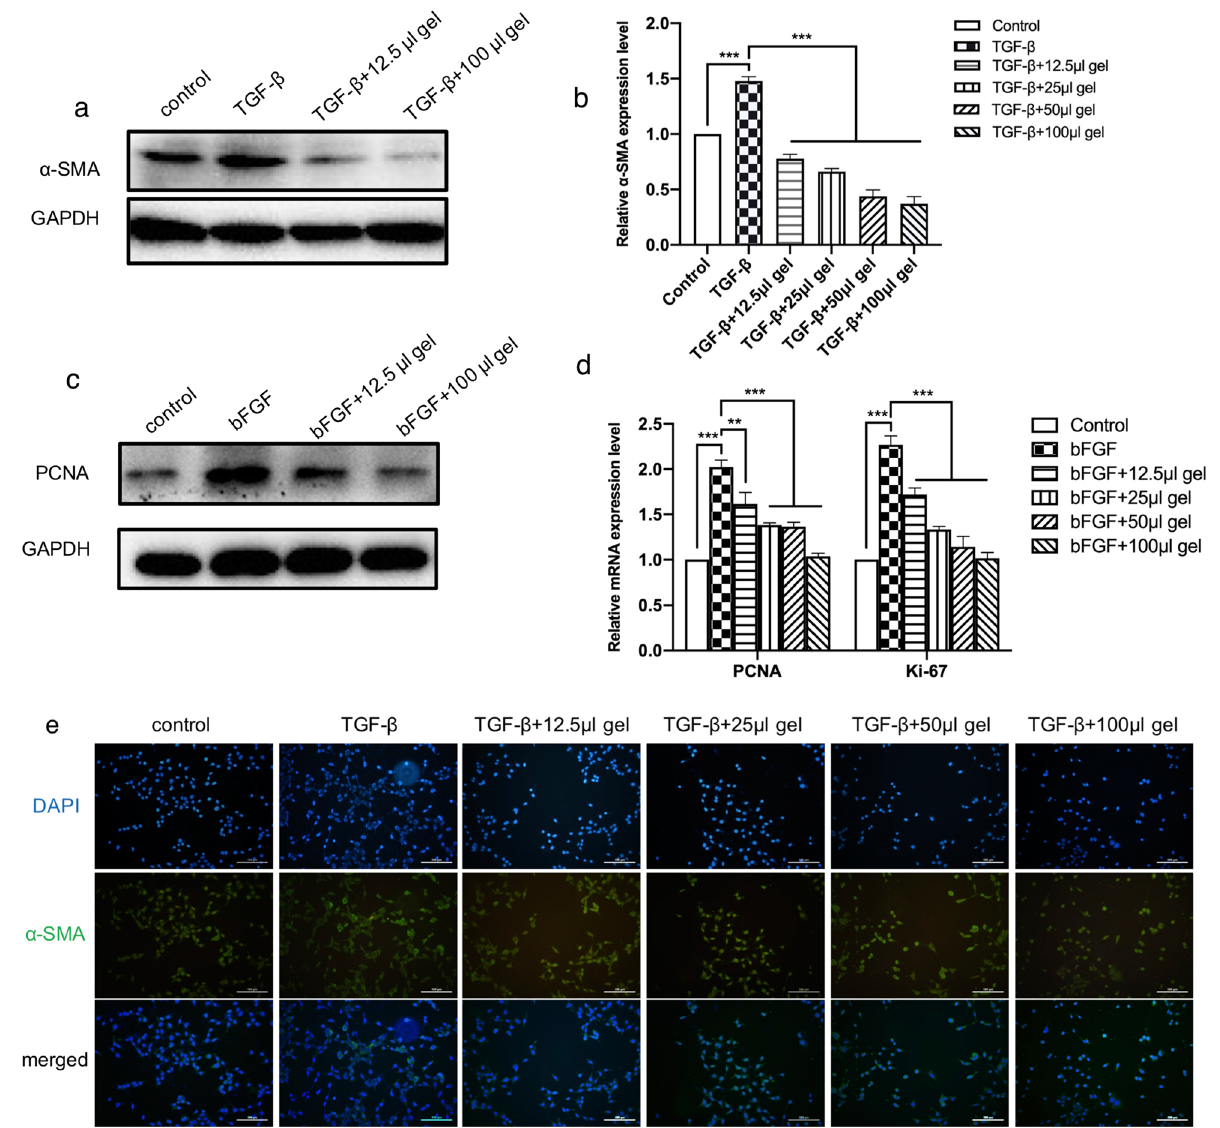
Figure 4. GenNLC-Dex-Mox hydrogel dose dependently inhibited SRA cell proliferation and EMT. The results of western blotting ( a ) and RT-PCR ( b ) both illustrated decreased expression of α-SMA in lens epithelial cells treated by the GenNLC-Dex-Mox thermoresponsive in situ gel in a dose-dependent manner. ( c , d ) PCNA and Ki-67 are cell proliferation-associated proteins. The GenNLC-Dex-Mox hydrogel treatment dose-dependently reduced the expression levels of PCNA as well as those of Ki-67. ( e ) Immunofluorescence illustrated the same trends of decreased expression of α-SMA protein in lens epithelial cells treated by increasing doses of the GenNLC-Dex-Mox thermoresponsive in situ gel. Results are shown as mean ± SD (n = 3). *P < 0.05, **P < 0.01, ***P <